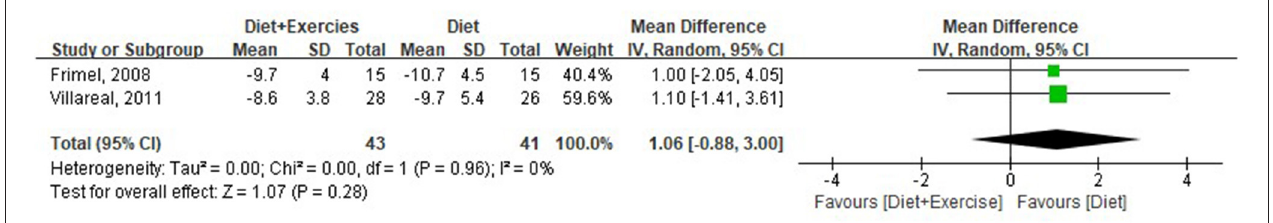
FIGURE 3 | Forest plot of the effects of dietary advice with or without exercise on body weight.